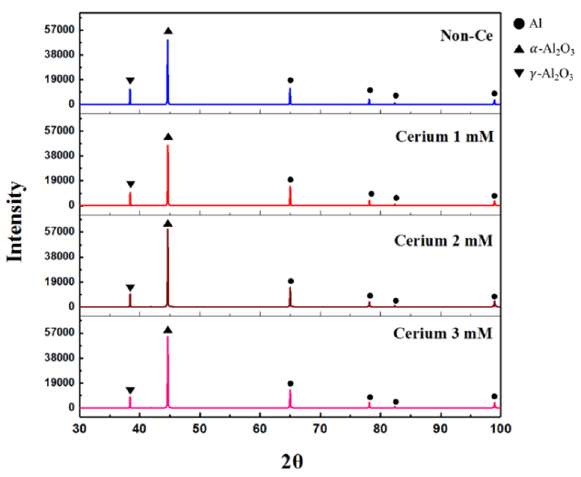
Figure 3. X-ray diffraction pattern of AAO film with change in Ce ion addition.